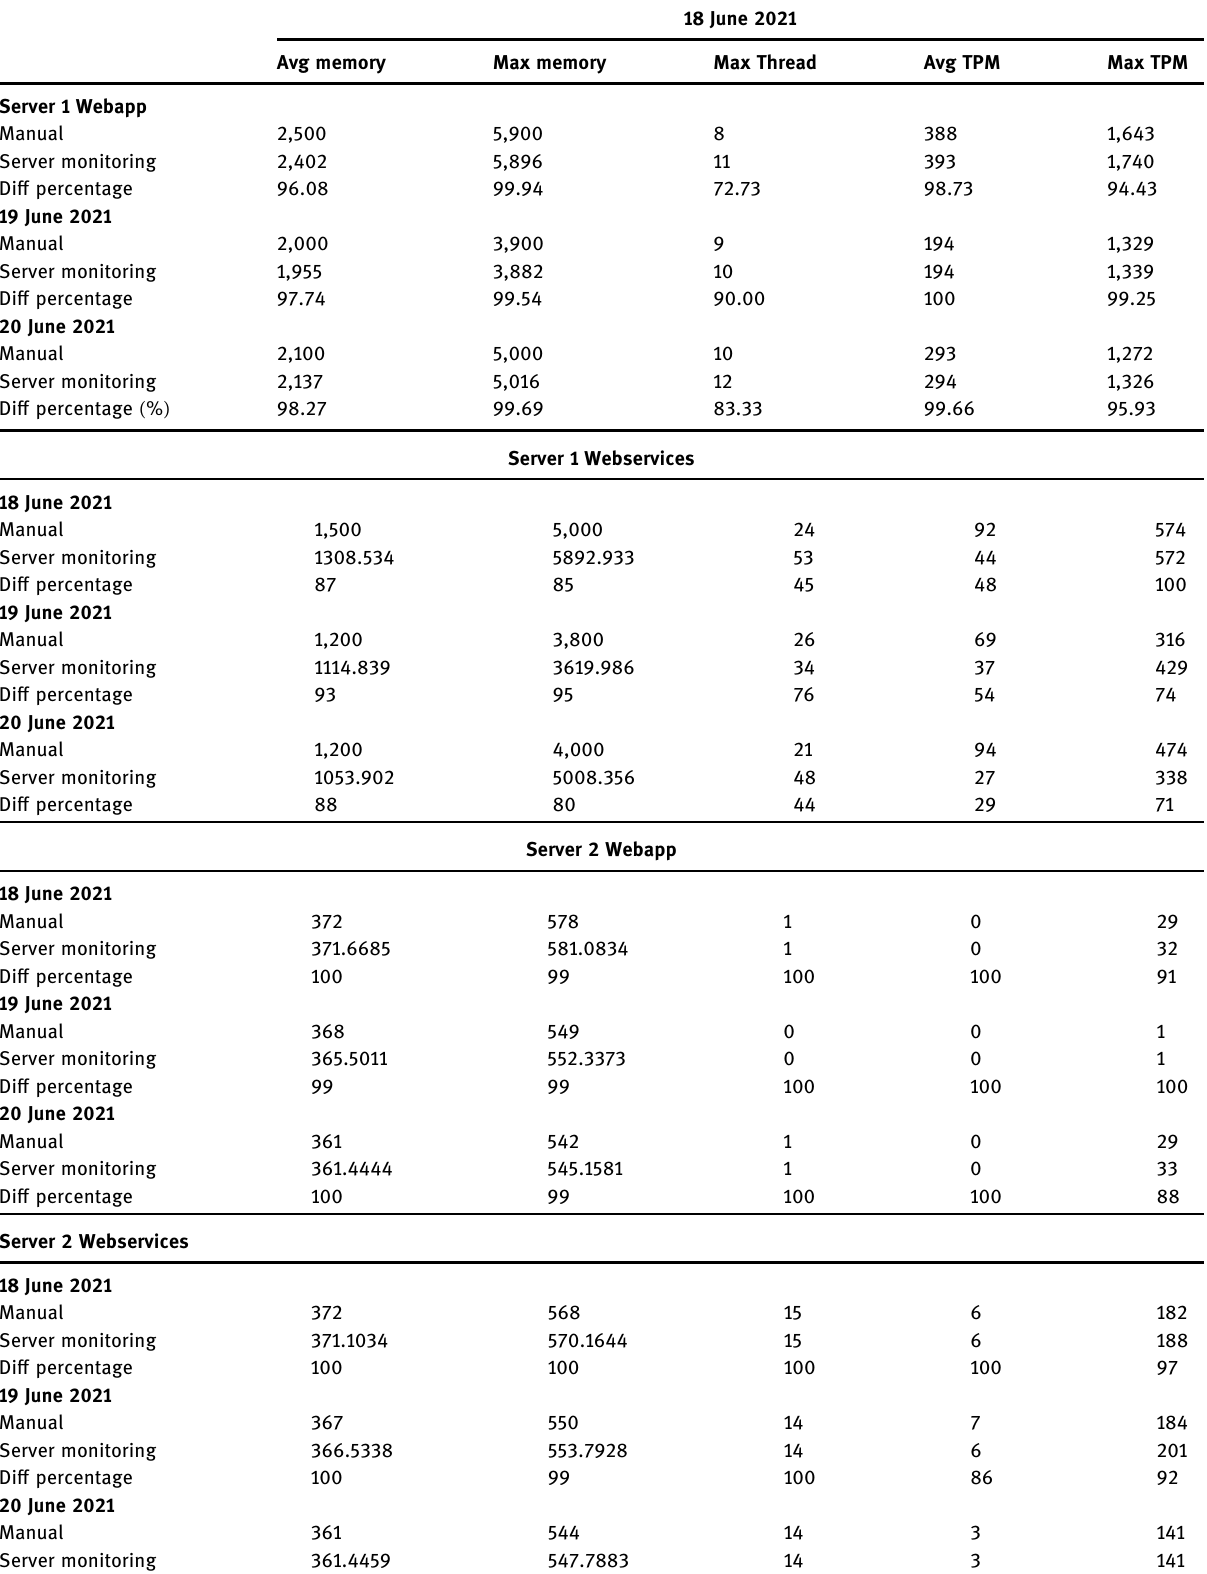
Table 8: The comparison data between JavaMelody and webapp server